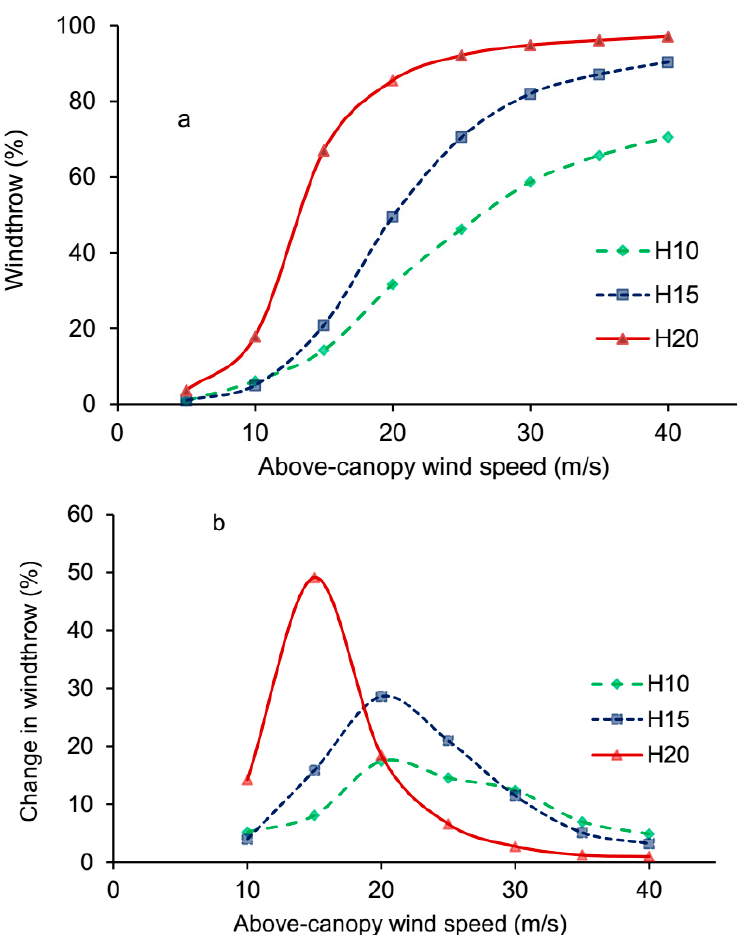
Figure 3. ( a ) Windthrow response to above-canopy wind speed across height classes. H10, H15, H20 correspond to 10 m, 15 m, and 20 m height classes, respectively. ( b ) Change in percent windthrow with increasing above-canopy wind speed across all stand types.